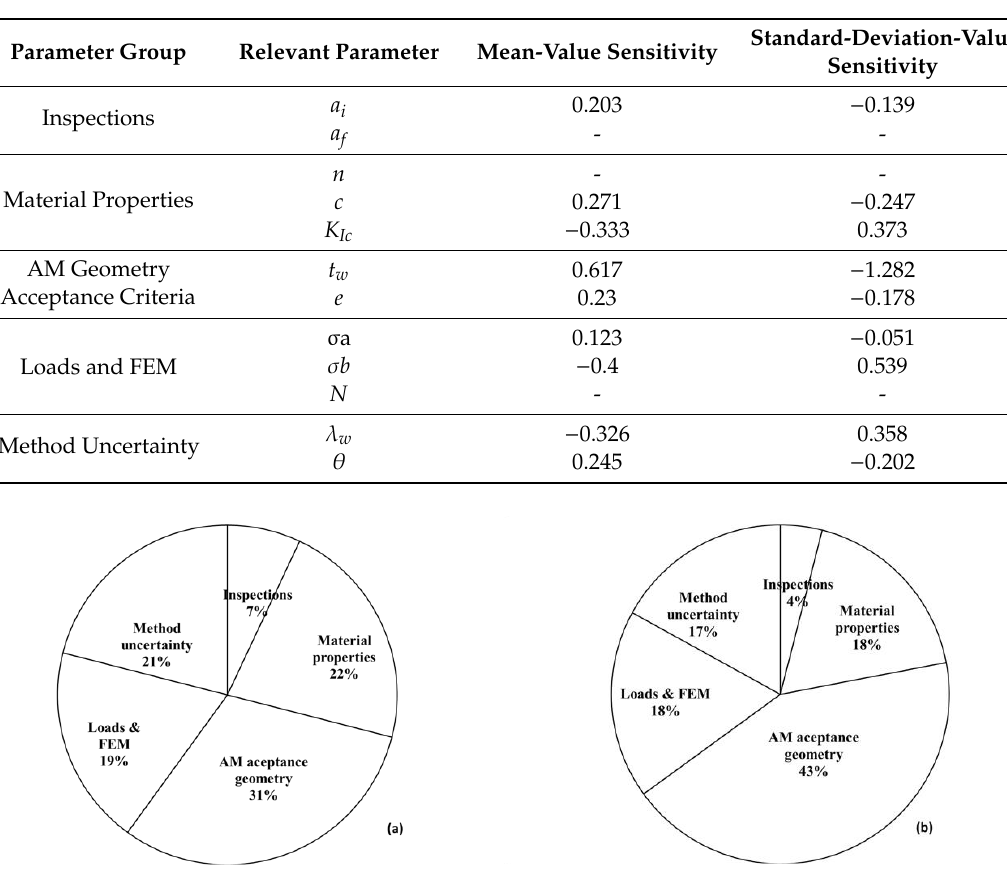
Table 4. AM-case PDF parameters reliability-index sensitivity.